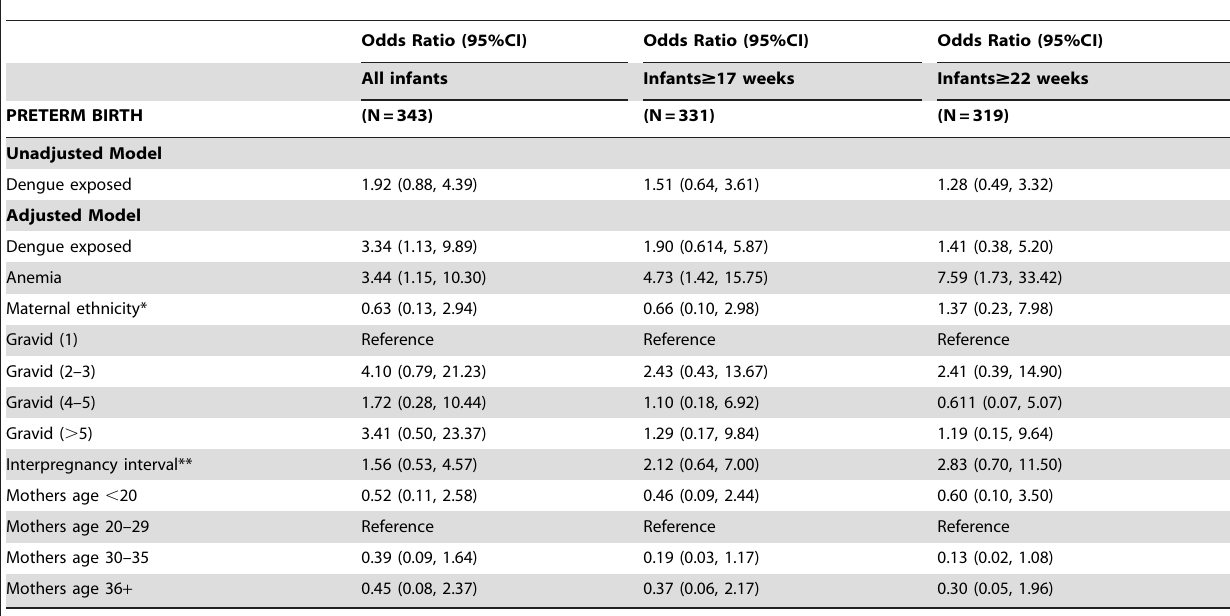
Table 4. Odds ratios for preterm birth among those with and without symptomatic dengue infection.